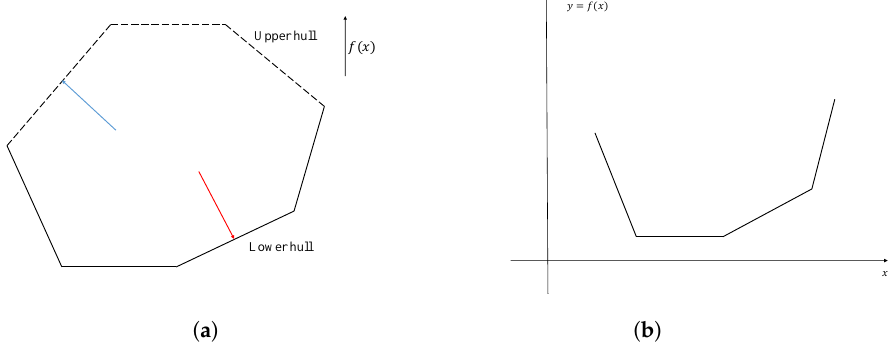
Figure 2. Constructing a convex function from the convex hull when d = 3. ( a ) Upper hull and lower hull of a convex hull ( b ) The convex function is formed by extracting the lower